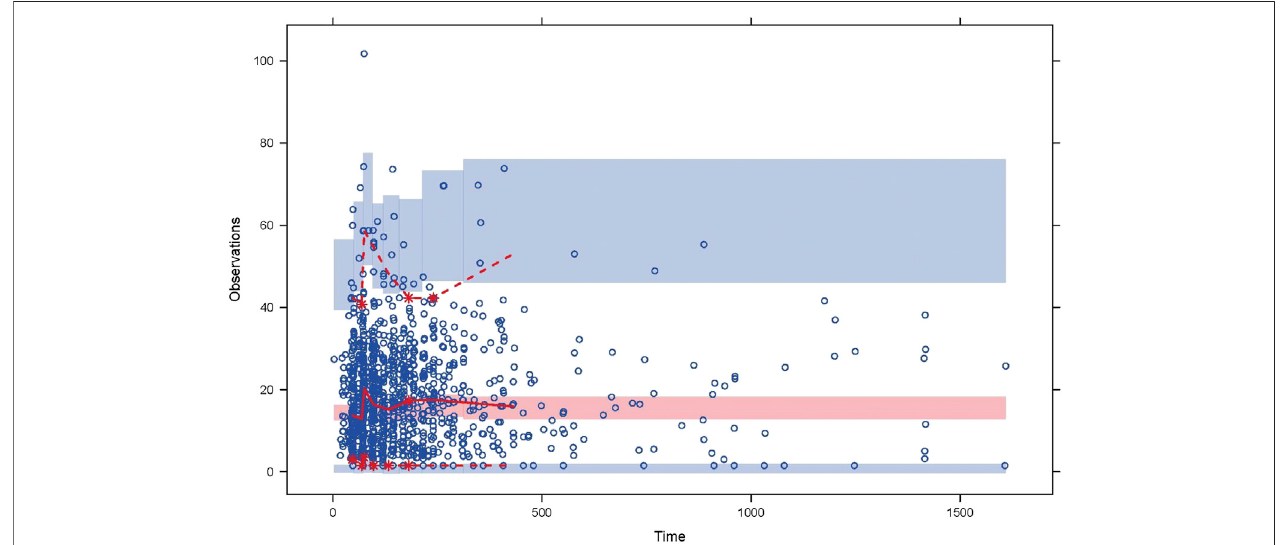
FIGURE 2 | Visual predictive check for the fi nal population pharmacokinetic model. The circles are the observations. The solid and dashed lines represent the median, 2.5th, and 97.5th percentiles of the observations; the shaded pink and blue areas represent the 95% con fi dence interval of the median, 2.5th, and 97.5th percentiles predicted by the